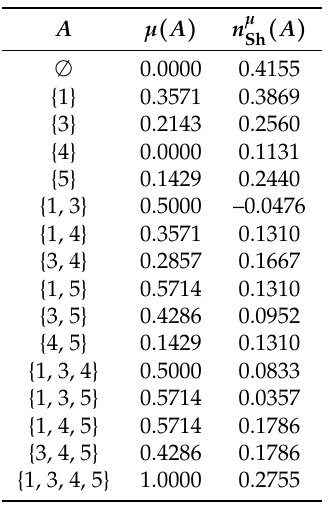
Table 3. The capacity on {1,3,4,5} and its Shapley nonadditivity